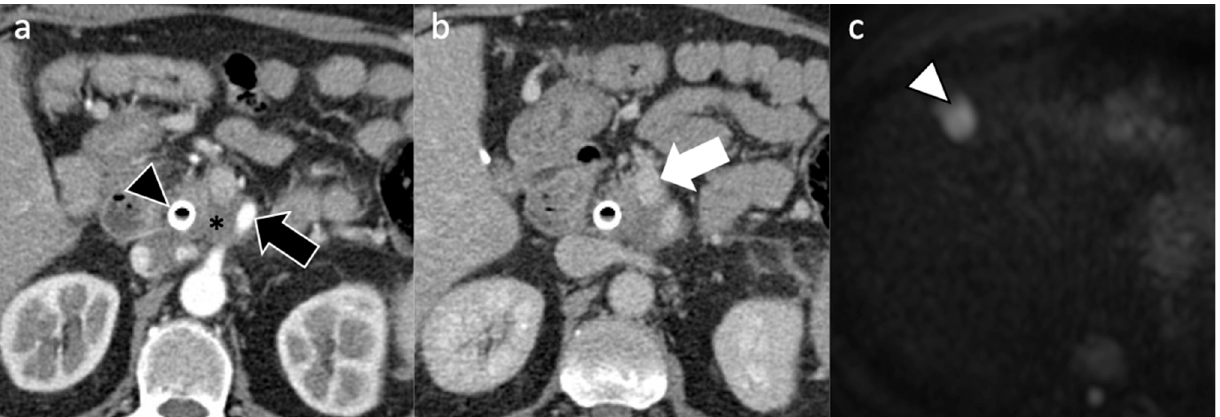
Figure 2. A 61-year-old man with non-resectable PDAC. Pancreatic CT scan on ( a ) arterial and ( b ) portal venous phases shows the presence of a biliary stent (black arrowhead) and a pancreatic mass (*) causing encasement of both superior mesenteric artery (black arrow) and vein (white arrow). The patient commenced modified FOLFIRINOX regimen at diagnosis. However, after 6 months, ( c ) liver MRI on diffusion weighted imaging showed appearance of liver metastasis in segment IV (arrowhead in c).